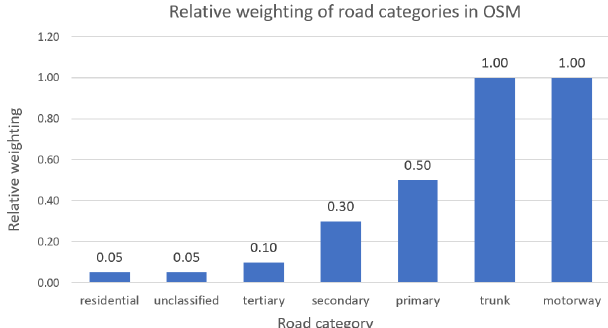
Figure 3. Weighting of the OpenStreetMap road categories used to redistribute EMEP traffic emissions for downscaling. Applied to all primary